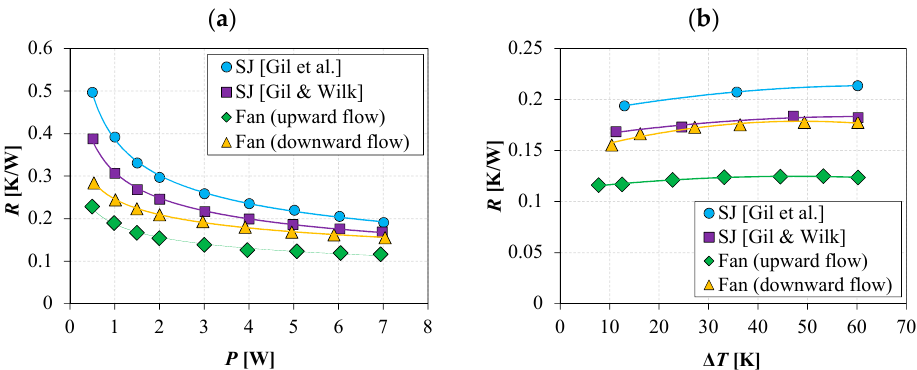
Figure 6. The thermal resistance of the heat sink as a function of ( a ) the power supplied to the cooling device; ( b ) temperature difference ∆𝑇 = (cid:4666)𝑇 (cid:2912) − 𝑇 (cid:2998) (cid:4667) at the power of 𝑃 = 7.0 W. Data from: Gil et